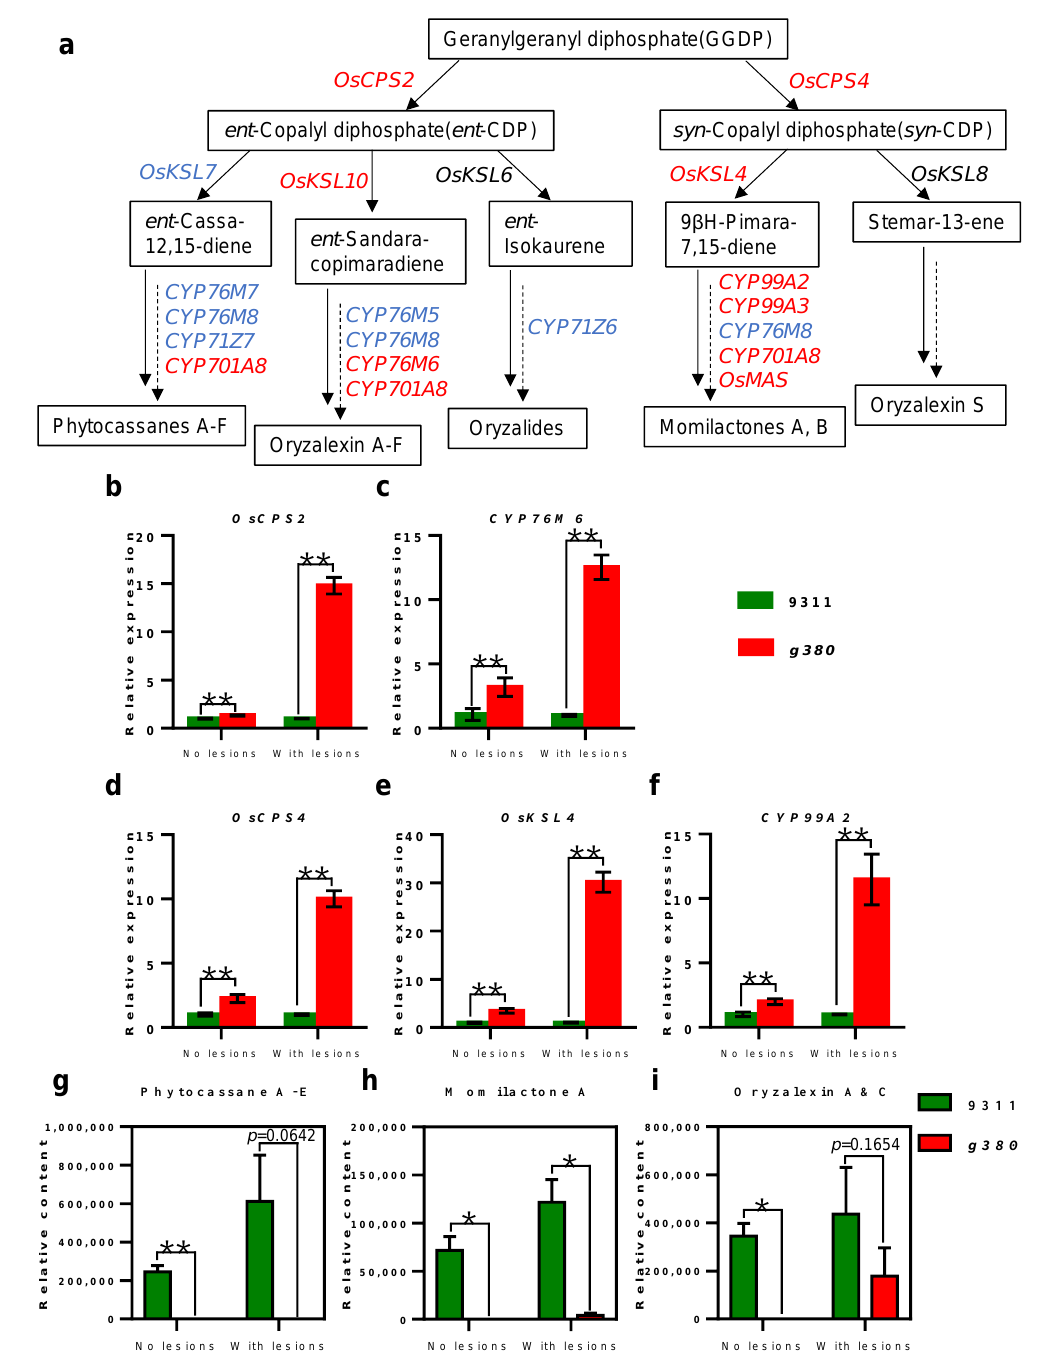
Figure 6. Decreased diterpenoid biosynthesis in g380 leaves. ( a ) Biosynthesis process of major diterpenoid phytoalexins in rice; substances in black bordered text boxes are metabolites; genes indicated in blue are deleted in g380 , genes indicated in red are DEGs upregulated in g380 , genes indicated in black have no significant difference in expression level between 9311 and g380 . The solid arrows represent the direct response, and the “solid + dashed” arrows represent that the process has not been explained sufficiently clearly. ( b – f ) Expression of non-deleted diterpenoid biosynthetic genes in 9311 and g380 before and after the formation of g380 lesions; ( b , c ) display genes located on chromosome 2; ( d – f ) display genes located on chromosome 4; error bar represents ± SD; ** indicates p < 0.01 by Welch’s t -test. ( g – i ) Diterpenoid phytoalexin content in 9311 and g380 leaves before and after g380 lesion formation; error bar represents ± SE; * indicates p < 0.05, ** indicates p < 0.01 by Welch’s t -test.